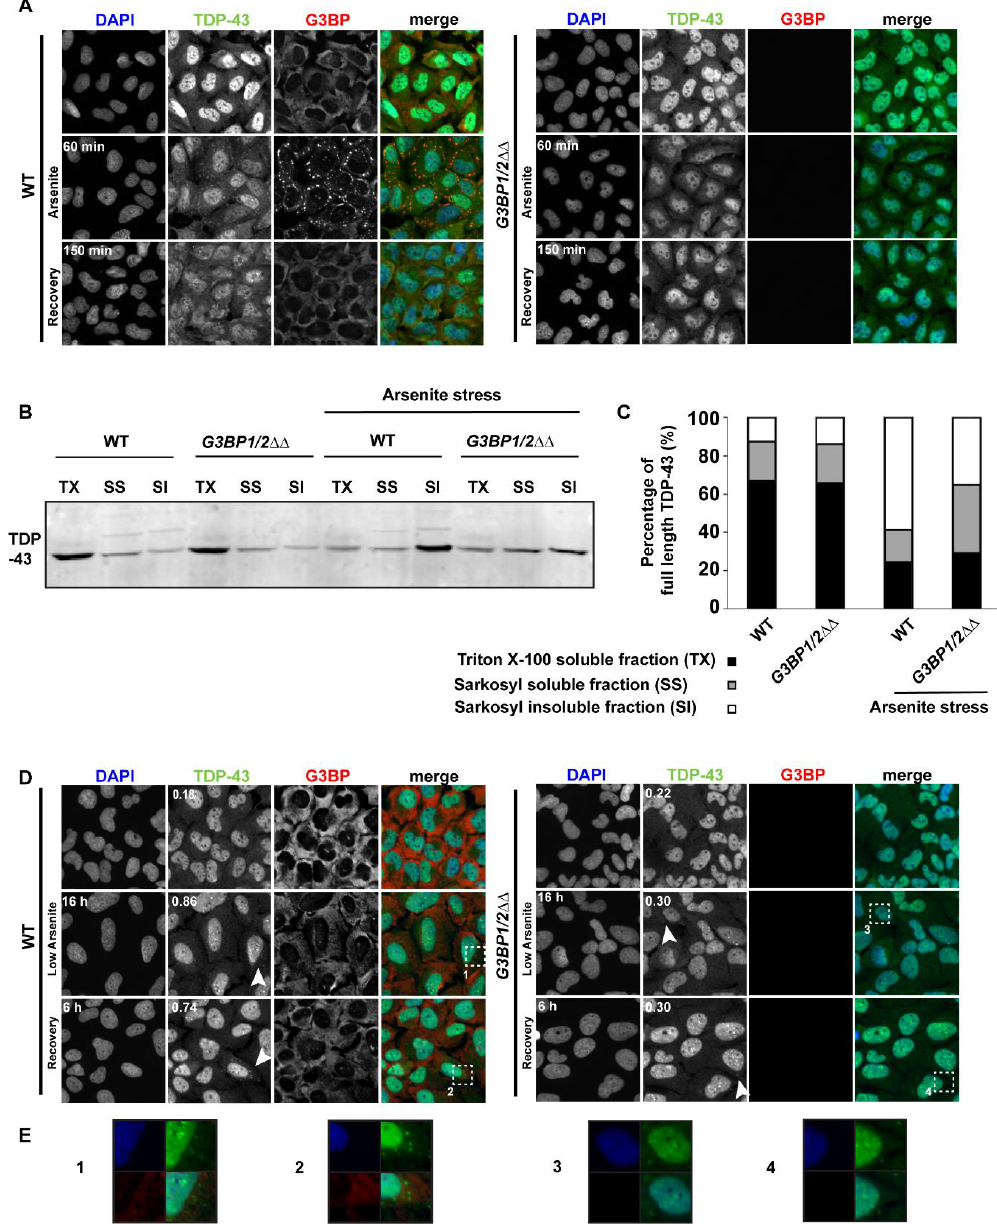
Figure 5. SG assembly mutants impair the formation of TDP-43 cytoplasmic foci in acute and chronic stress. ( A ) U2-OS (WT) and G3BP1/2ΔΔ cells were unstressed, stressed with 0.5 mM sodium arsenite for 1 h or stressed with 0.5 mM sodium arsenite for 1 h followed by recovery for 2.5 h. Immunofluorescence for TDP-43 utilized the Proteintech 60019-2-Ig antibody, with G3BP staining serving as an SG marker (and conformation of KO status). ( B ) Endogenous TDP-43 solubility in WT and G3BP1/2ΔΔ cells was determined via differential solubilization using Triton X-100 (TX), Sarkosyl (SS) and SDS (SI). Western blotting was conducted with the Proteintech 10782-2-AP antibody. ( C ) Quantification of ( B ). ( D ) U2-OS (WT) and G3BP1/2ΔΔ cells immunostained as in ( A ) were left unstressed, stressed with 0.05 mM sodium arsenite for 16 h or stressed with 0.05 mM sodium arsenite for 16 h, followed by recovery for 6 h. Numbers indicated in TDP-43 column indicate average number of TDP-43 foci / cells (see also Supplementary Table S2). Arrowheads indicate cells with TDP-43 foci. Immunofluorescence (IF) was carried out as in ( A ). ( E ) Zoom panels indicated by white boxes in ( D